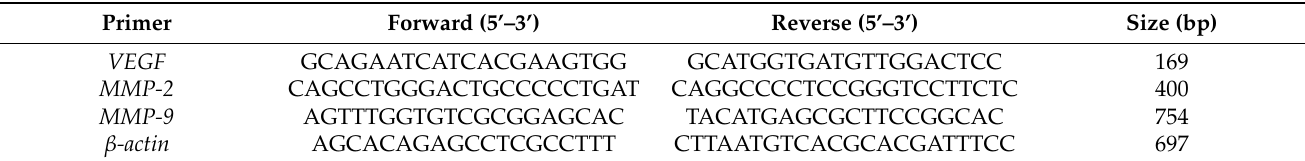
Table 1. List of primers used to determine gene expressions of VEGF , MMP-2 , and MMP-9 using RT-PCR. The sequence of designed primers for each gene is shown as forward and